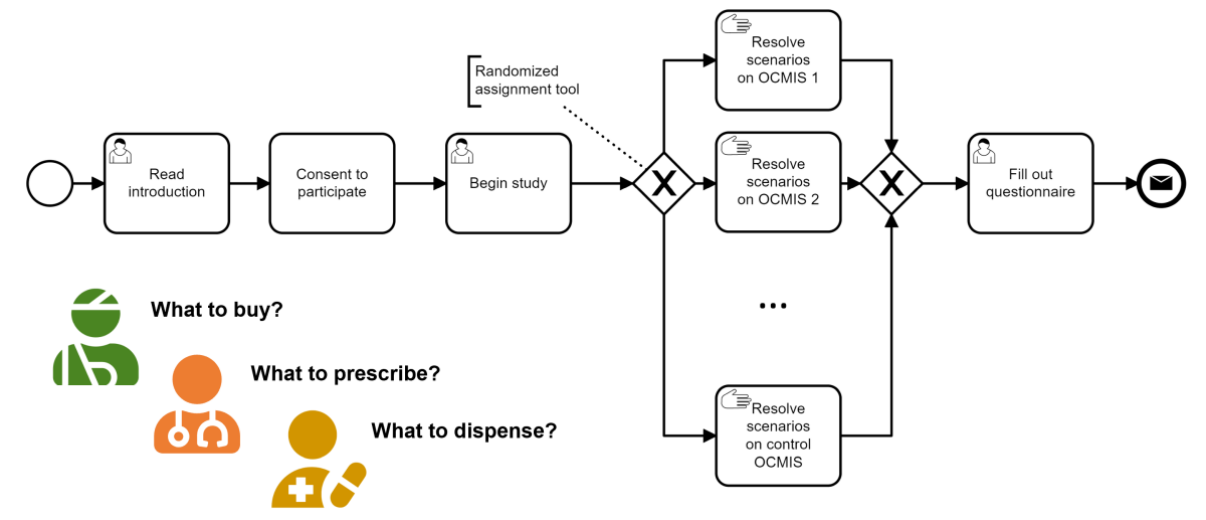
Figure 1. A graphical view of the study procedure is shown in a Business Process Model and Notation (BPMN). After reading the introduction and consenting to participate, the participants are randomly assigned to either the case group, which uses an online consumer medication information system (online system 1...n), or the control group, which uses the reference implementation (control system). A post hoc questionnaire was performed before concluding the study. OCMIS: online consumer medication information